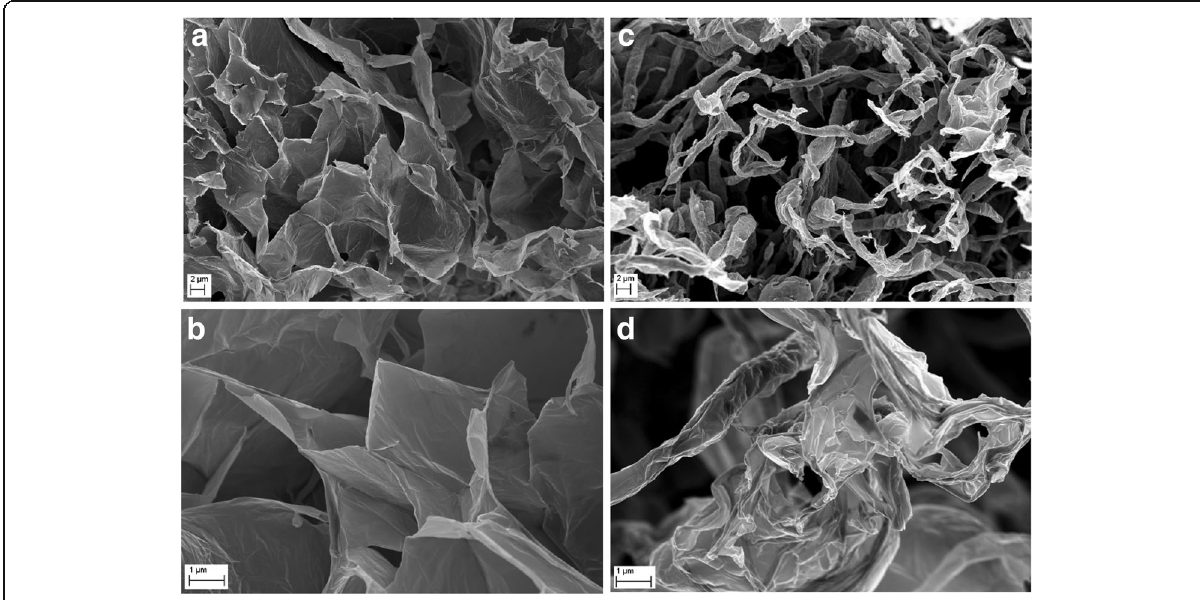
Fig. 5 Comparison of morphology of lyophilized GO flakes ( a , b ) and GO flakes after ultrasonic treatment ( c , d ) using scanning electron microscopy. The decrease of the average GO particle size after ultrasonic treatment was caused by defragmentation or folding of the GO flakes